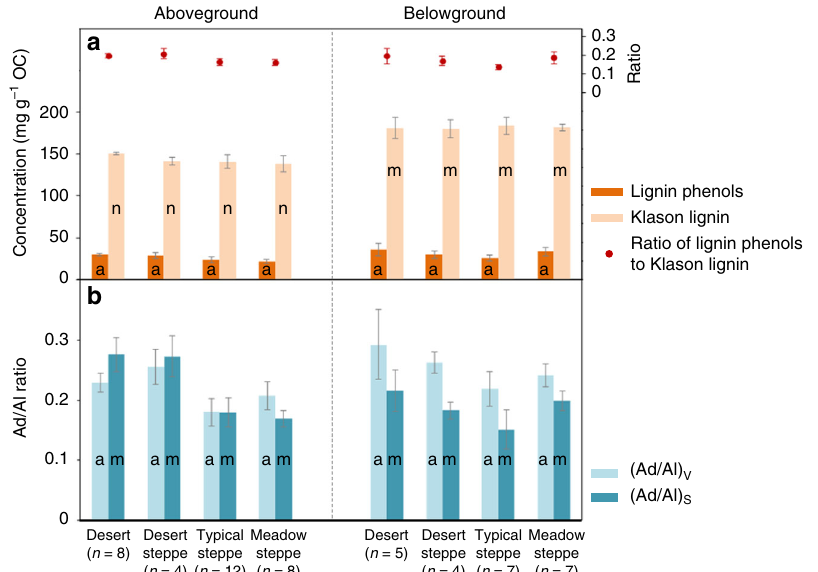
Fig. 2 Lignin concentration and composition in the overlaying vegetation of Mongolian grasslands. Organic carbon (OC)-normalized concentrations of lignin phenols and Klason lignin and the ratio of lignin phenols: Klason lignin ( a ) and the acid-to-aldehyde (Ad/Al) ratios of vanillyl (V) and syringyl (S) phenols ( b ). Error bars represent the standard error of the mean (s.e.m.) with the number of replicates (n) indicated in the parenthesis. Letters indicate different levels for the same parameter among vegetation types ( p < 0.05)